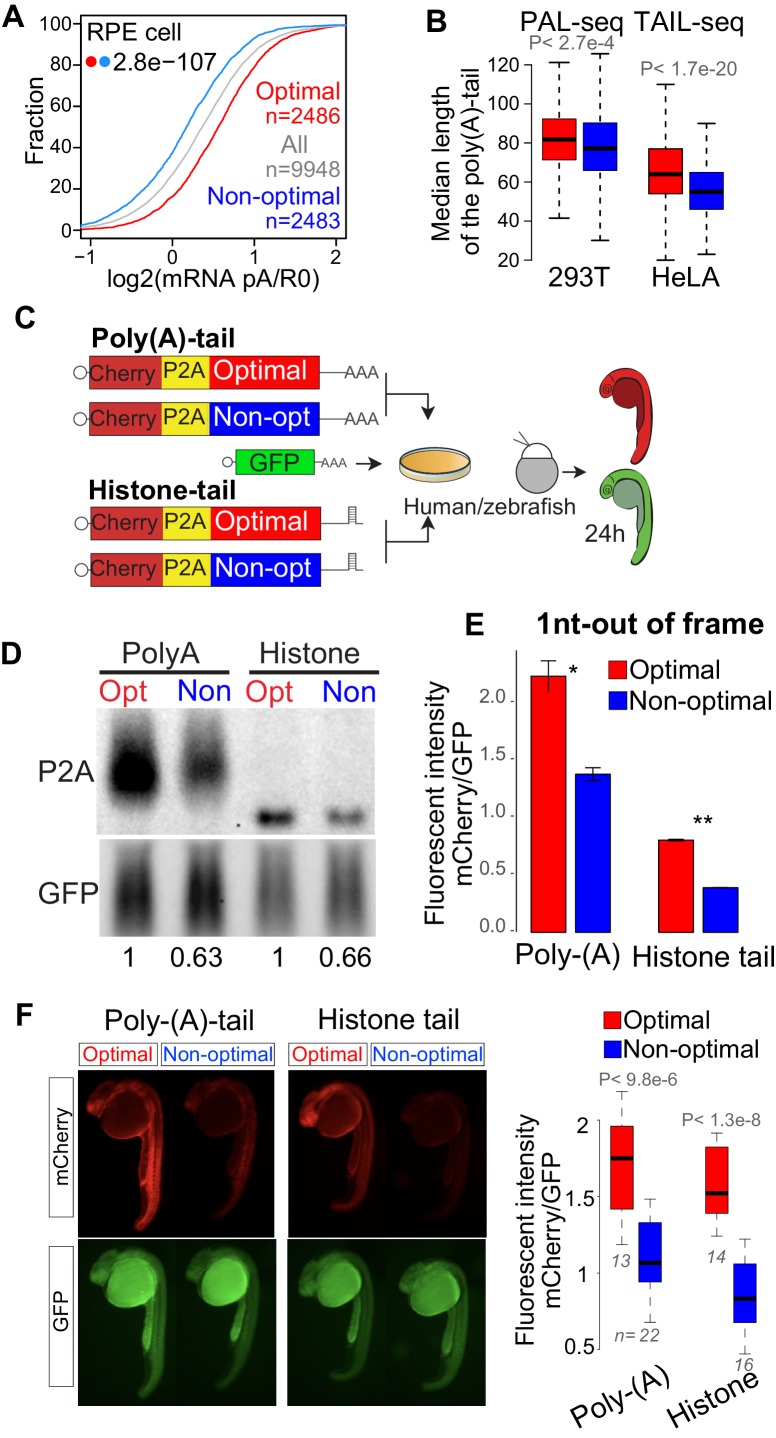
Poly(A)-tail is affected but not required for the codon optimality mechanism in human and zebrafish.(A) Cumulative distribution of the poly(A) selected mRNA and total mRNA ratio in RPE cells showing that mRNA enriched in optimal codons present higher poly(A) ration than mRNA enriched in non-optimal codons, p-value indicated, Wilcoxon rank-sum test. (B) Box plots showing the length of the poly(A)-tails of mRNA enriched in optimal or non-optimal codons measured by PAL-seq (Subtelny et al., 2014) or TAIL-seq (Chang et al., 2014), the top 500 genes enriched in optimal or codons genes are used for each group, p-value indicated, Wilcoxon rank-sum test. (C) The 1nt-out of frame reporter containing either poly(A)- or histone-tail were transfected into human cells or co-injected into single-cell stage zebrafish embryos with a GFP construct as internal control. (D) Northern-blot showing that the 1nt-out of frame reporters enriched in optimal codons presents higher level of mRNA comparing to the counterpart enriched in non-optimal codon containing either a poly(A)- or histone- tail signal at 24 hr post-transfection. GFP was used as internal control. Relative normalized quantifications are indicated. (E) The 1nt-out of frame reporters enriched in optimal codons displayed higher fluorescent intensity than it counterparts enriched in non-optimal codons measure by cytometry, independent of the poly(A)- or histone-tail used. Unpaired t.test is used. *p<0.01, **p<0.005. (F) Fluorescence microscopy images of representative embryos at 24 hr post injection with the indicated 1nt-out of frame reporter and GFP. Box plot displays fluorescence quantification of 24 hr embryos injected with each reporter. mCherry fluorescence intensity was normalized to GFP intensity in each embryo, Poly-(A), n > 13 pairs, p = 9.3e-06 and Histone, n > 14 pairs, p = 1.3e-08, Wilcoxon rank-sum test.
10.7554/eLife.45396.015Figure 4—source data 1.Reporter sequences and oligos used for Figure 4.